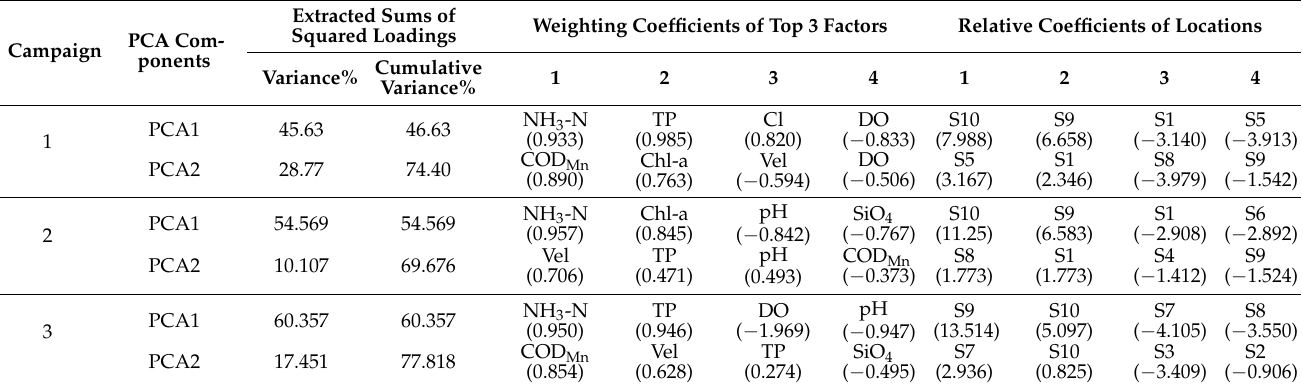
Table 1. Results of the PCA analysis on data from three sampling campaigns.